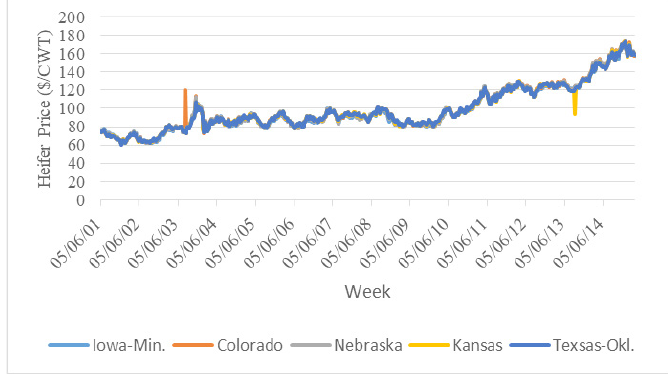
Figure 1b: Weekly Live Heifer Prices ($/CWT), May 2001-March